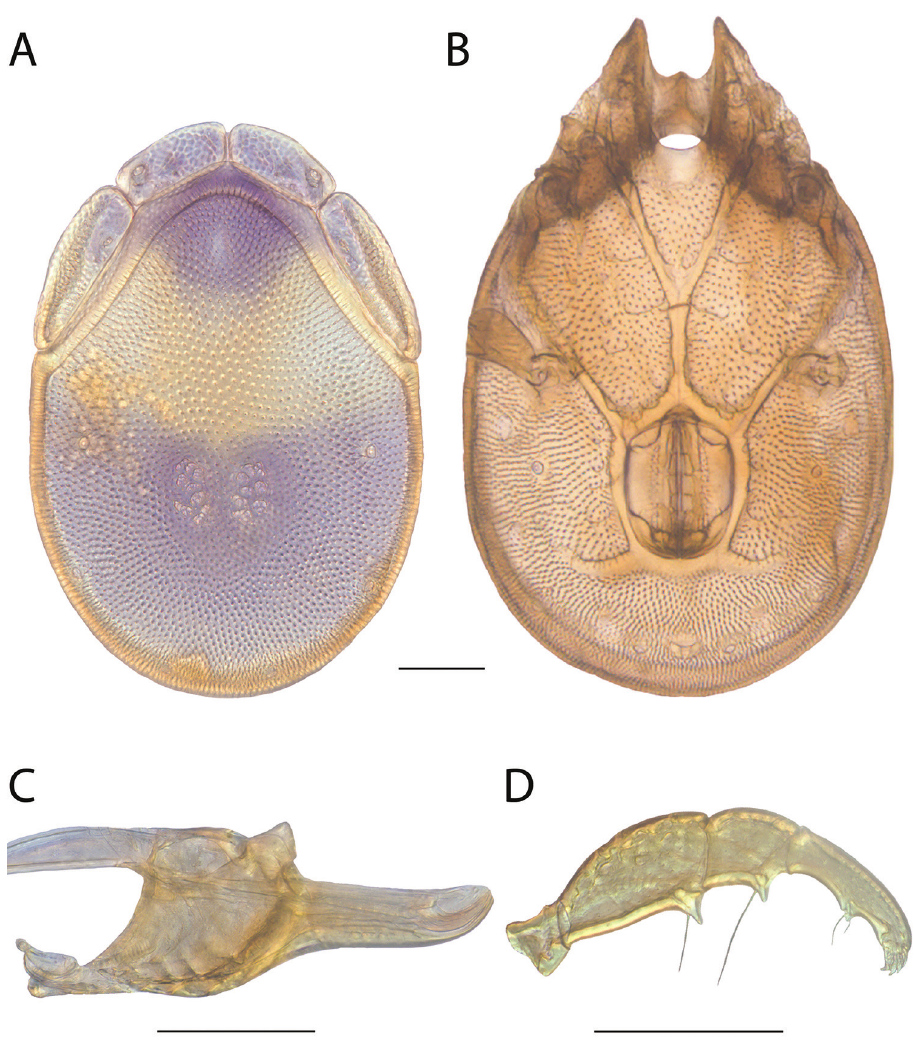
Figure 163. Torrenticola neoanomala male: A dorsal plates B venter (legs removed) C subcapitulum D pedipalp (setae not accurately depicted). Scale = 100